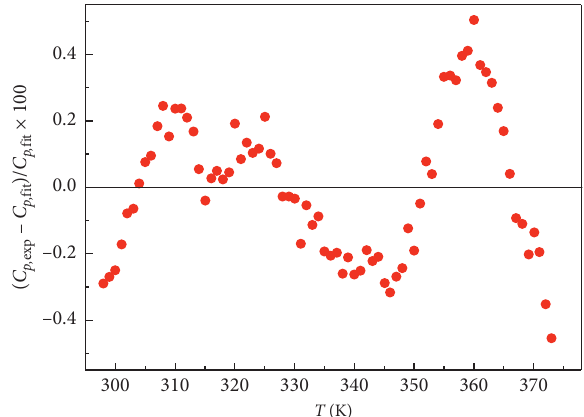
Figure 4: The deviations of the experimental and fitting values.